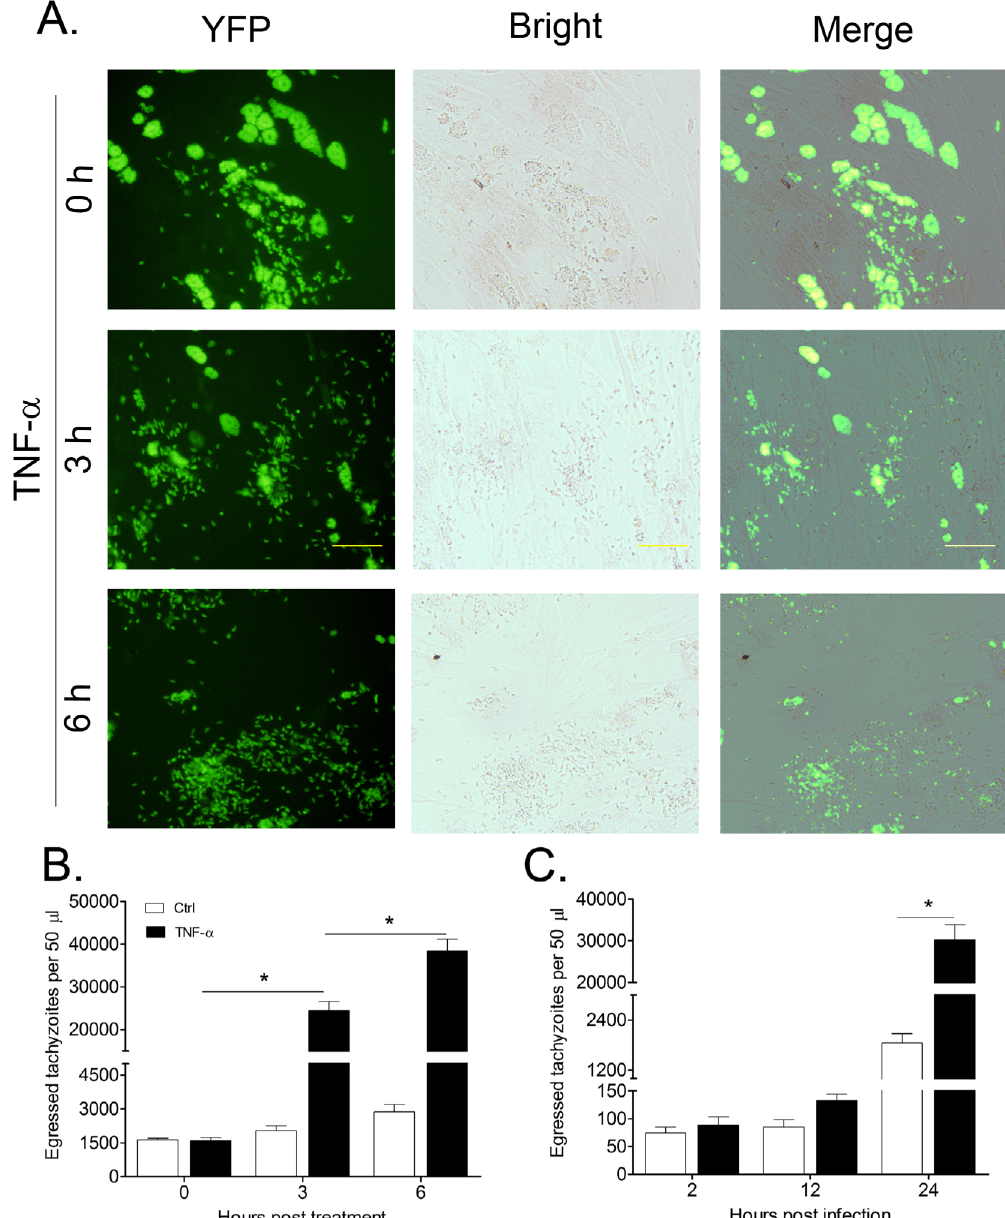
Figure 1. TNF- a triggered egress of tachyzoites from infected HFFs. A and B, HFFs were infected with T. gondii (RH strain) for about 36h, followed by treatment with 10ng/mL TNF- a for 3h or 6h. Egressed parasites were calculated using FACS. C, HFFs were infected with T. gondii (RH strain) for different time periods followed by TNF- a treatment (10 ng/mL, 6 h) and an egress assay. Bars represent means ± SDs of fi ve replicates. This experiment was repeated three times with similar results, * p < 0.05. Bar=50 m